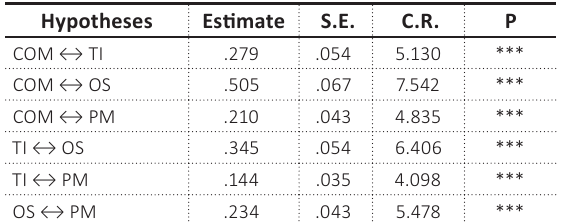
Table 4. Regression weights of estimation